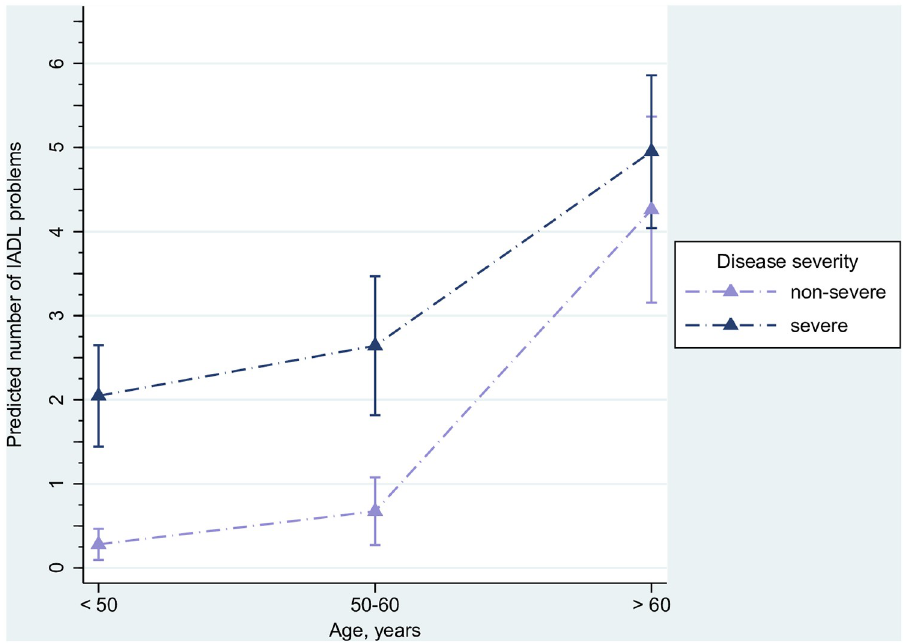
Fig 3. Effect of the interaction of age and disease severity on the number of predicted IADL problems (triangles) with 95% confidence intervals (capped lines). Estimated from zero-inflated Poisson regression. Predictions are adjusted for other factors in the model. Predictors included in the logistic part (excess zeros) were the following: age group, interaction of age and disease severity, setting (Hubei vs. other province), Tibetan ethnicity (reference: Han), smoking history, and comorbid conditions. Predictors included in the count part were: disease severity, interaction of age and disease severity, symptoms, and infection scope. The model has been estimated for 431 cases (because of one missing date of